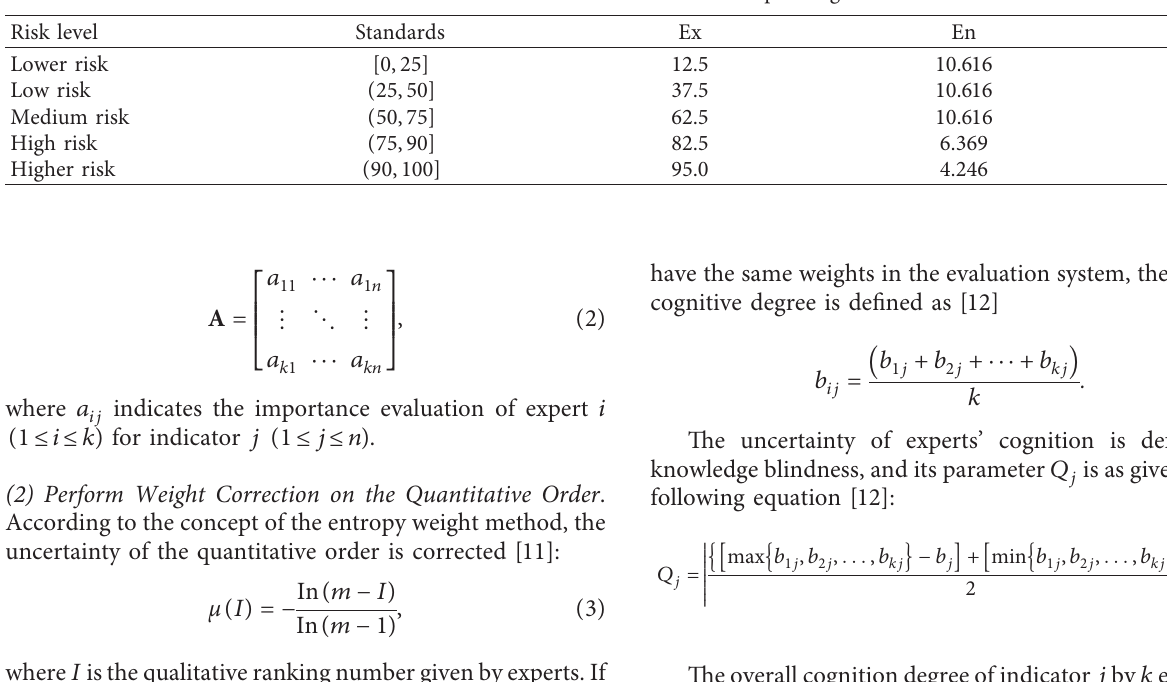
Table 3: Standard risk level classification and corresponding cloud